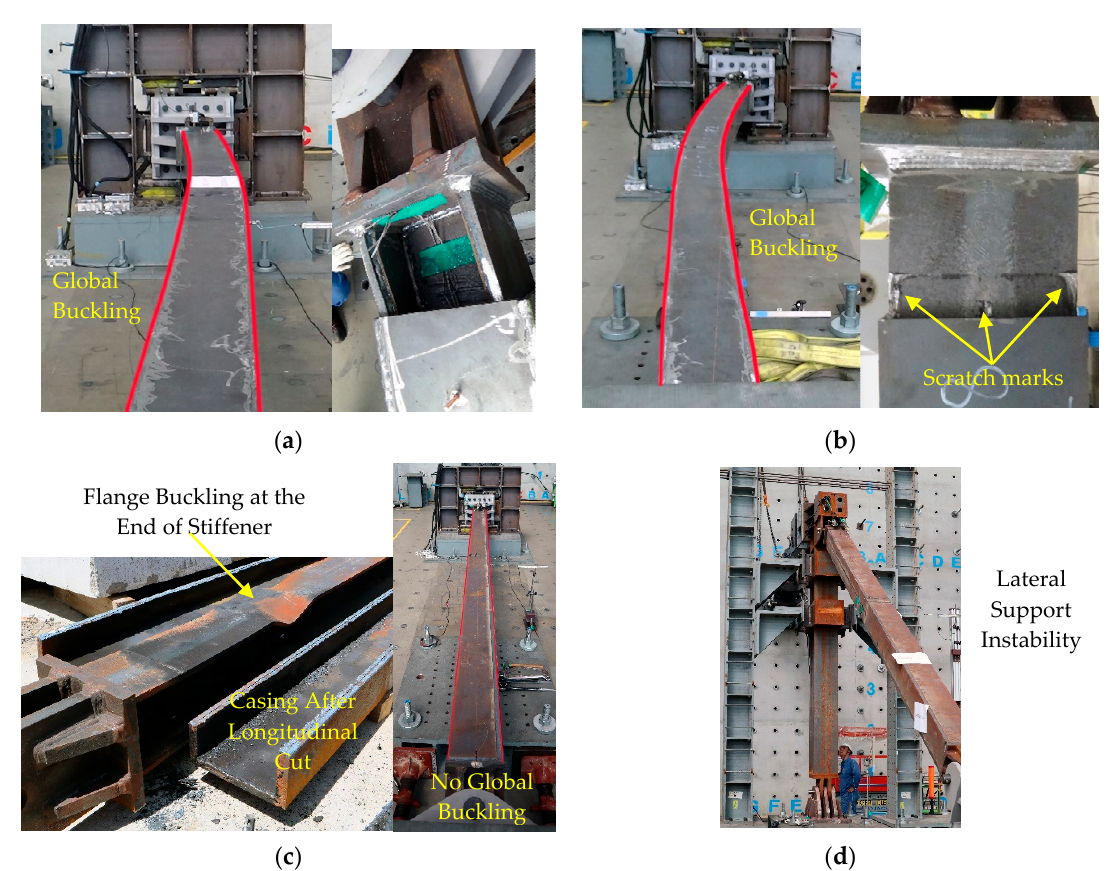
Figure 7. Failure mode of test specimens: ( a ) Specimen 1—global buckling and unconstrained-length deformation; ( b ) Specimen 2—global buckling and scratch marks on the unconstrained length; ( c ) Specimen 3—flange buckling and no global buckling; ( d ) Specimen 4—lateral support instability.